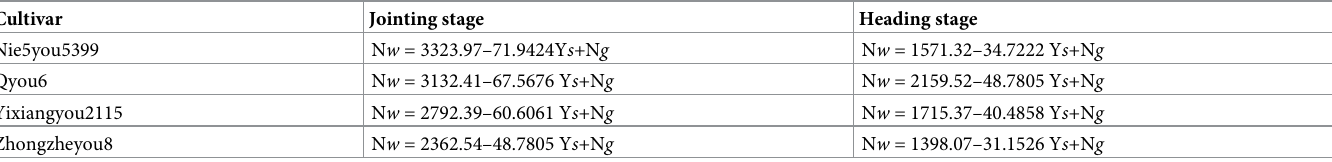
Table 3. General mathematical expression of the leaf value model at the jointing and heading in the four rice cultivars. Cultivar Jointing stage Heading stage